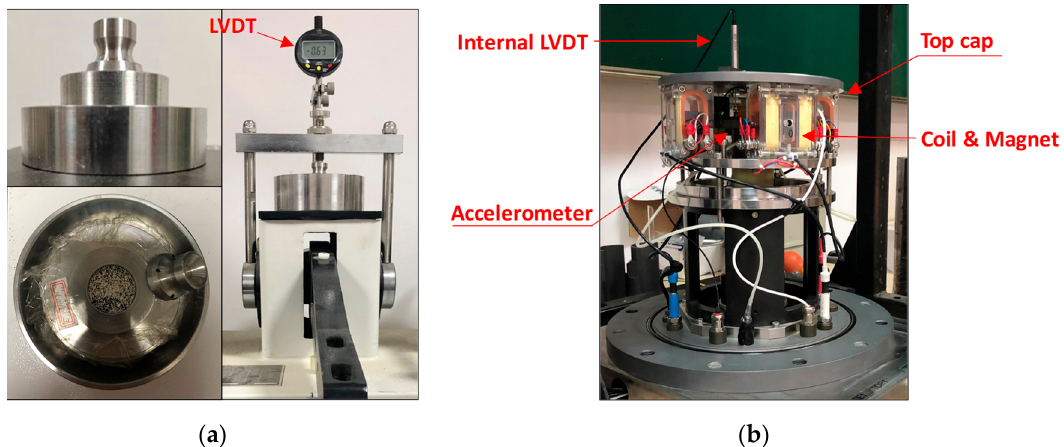
Figure 2. Test equipment: ( a ) Modified oedometer cell; ( b ) resonant column apparatus (LVDT: linear variable differential transformer).